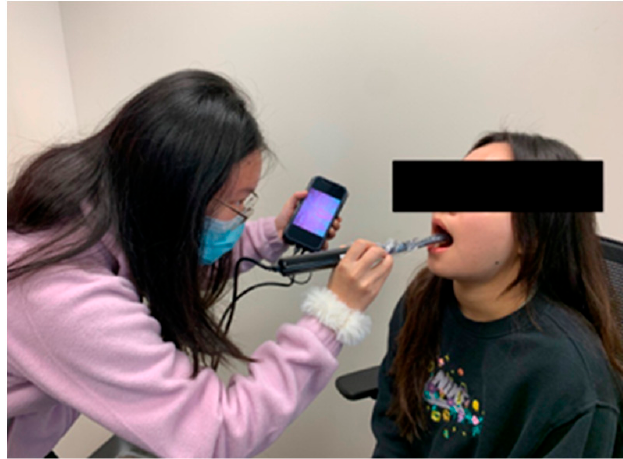
Figure 3. Non-specialist use of oral cancer screening platform in community setting.